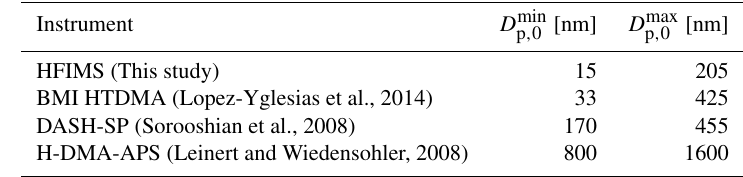
Table 1. Dry particle diameter range ( D min – D max ) of four particle hygroscopicity instruments including the HFIMS. Diameter ranges of p , 0 p , 0 the HFIMS, Brechtel Mfg. (BMI), HTDMA and DASH-SP were estimated based on growth factors ranging from 0.8 to 2.2. The DASH-SP dry size range was estimated for a 5Lmin − 1 DMA sheath flow rate, 281V minimum classifying voltage and 135nm cut size of the OPC as